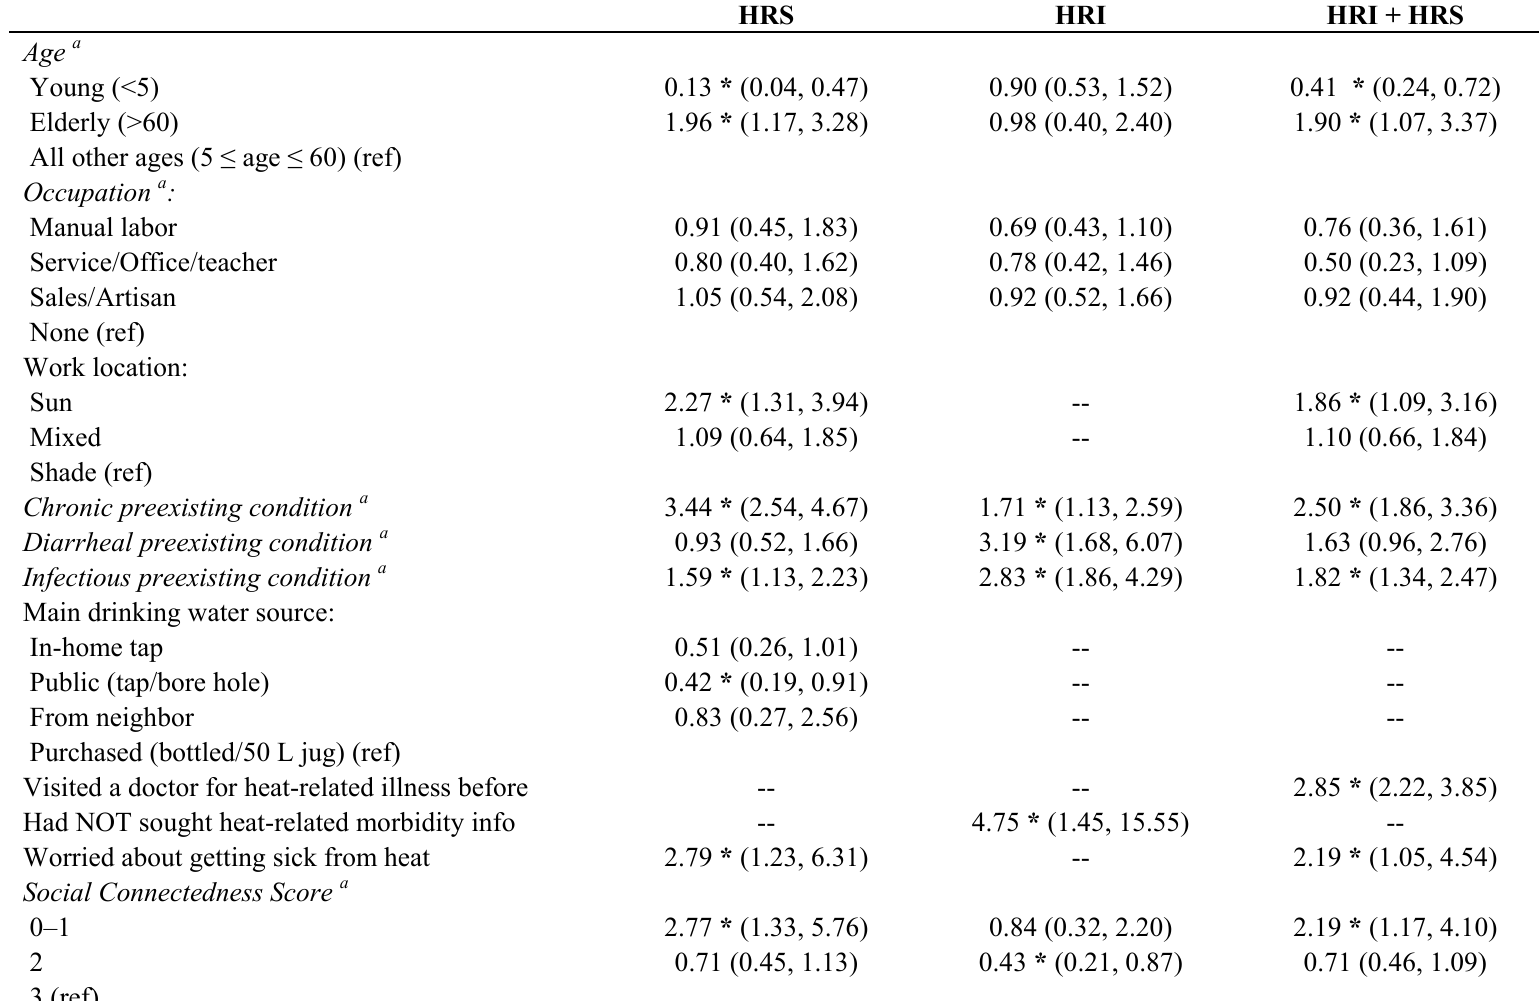
Table 4. Association between the heat-related outcomes and age, occupation, and preexisting conditions (adjusted ORs and 95% confidence intervals). HRS HRI HRI + HRS Age a Young (<5) 0.13 * (0.04, 0.47) Elderly